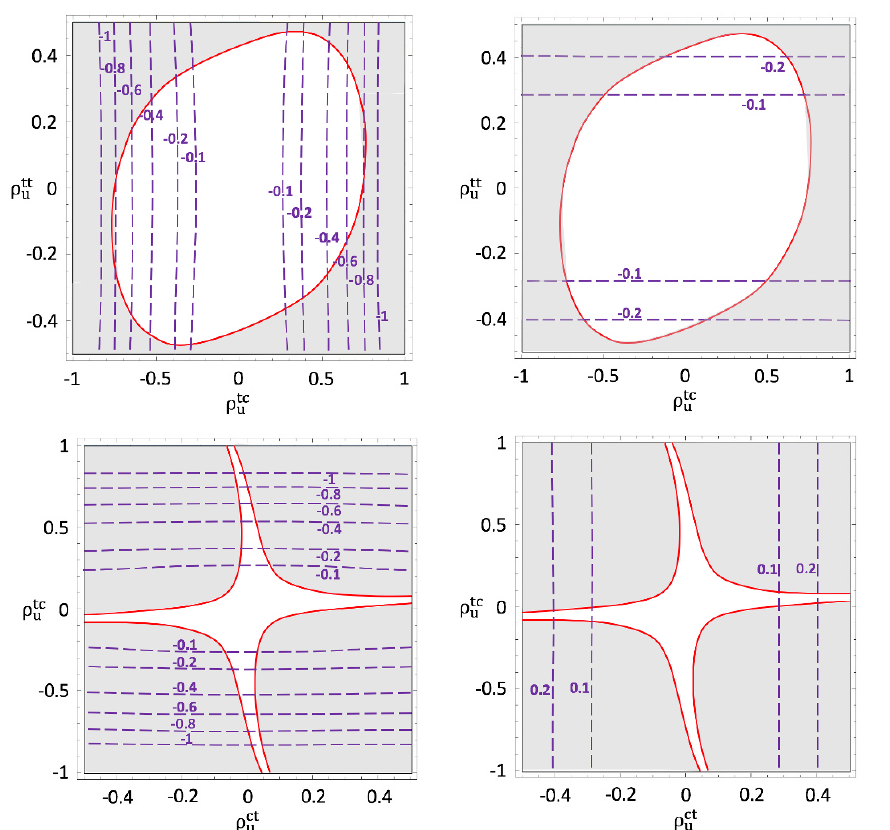
Figure 5 . (cid:26) tt vs. (cid:26) ct (upper) and (cid:26) tc vs. (cid:26) ct (lower) in the case (A) with m u u u u gray region is excluded by the B s (cid:0) B s mixing and the red lines correspond to the borders. The dashed purple lines denote the predictions of (cid:1) C 9 (left) and (cid:1) C 10 (right).